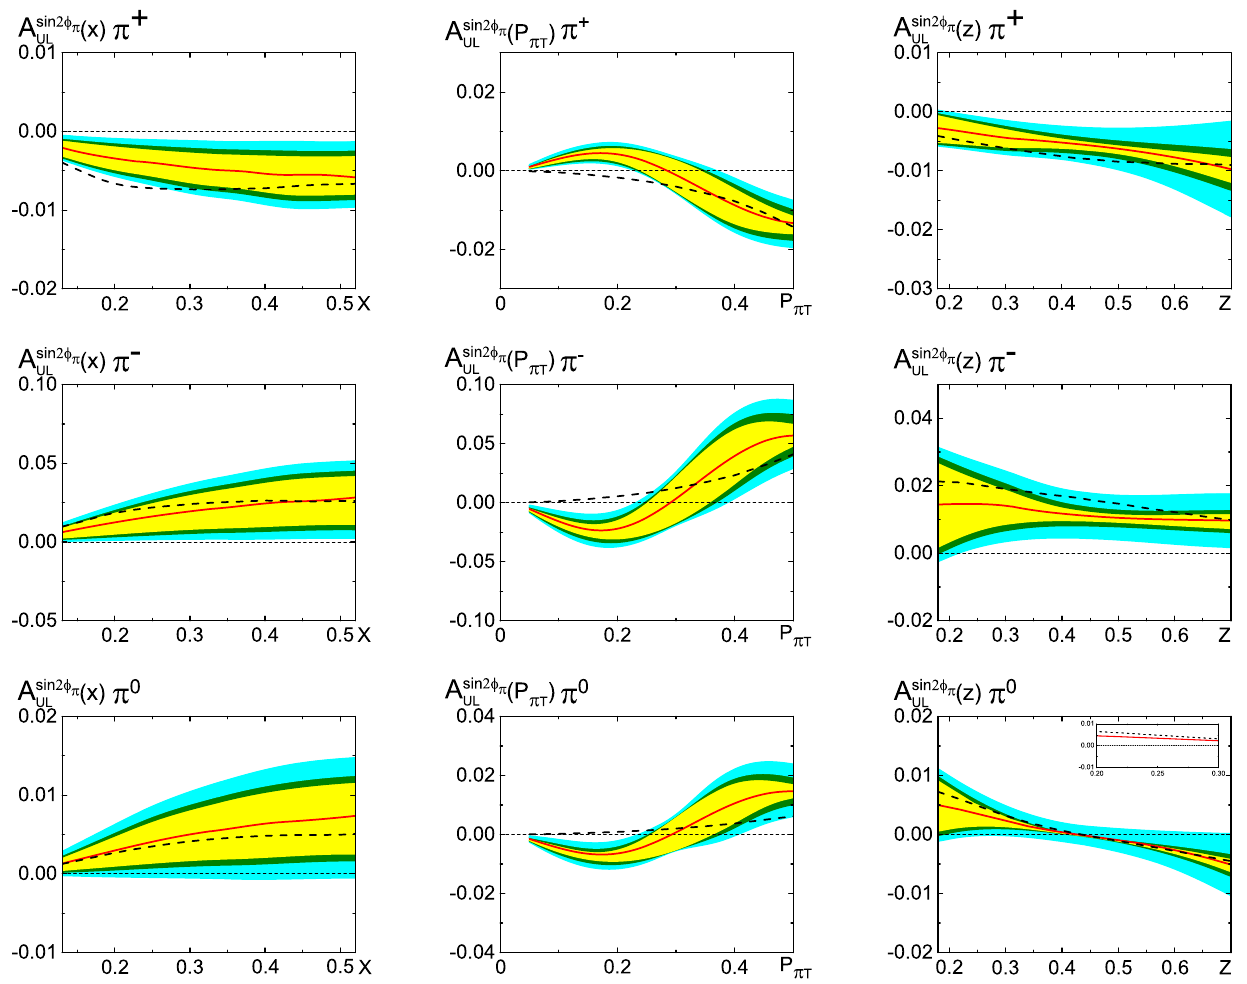
φ h Fig. 6 The A sin2 asymmetry as functions of x , P π T and z for π + (upper panel), π − (centre panel) and π 0 (lower panel) productions at UL